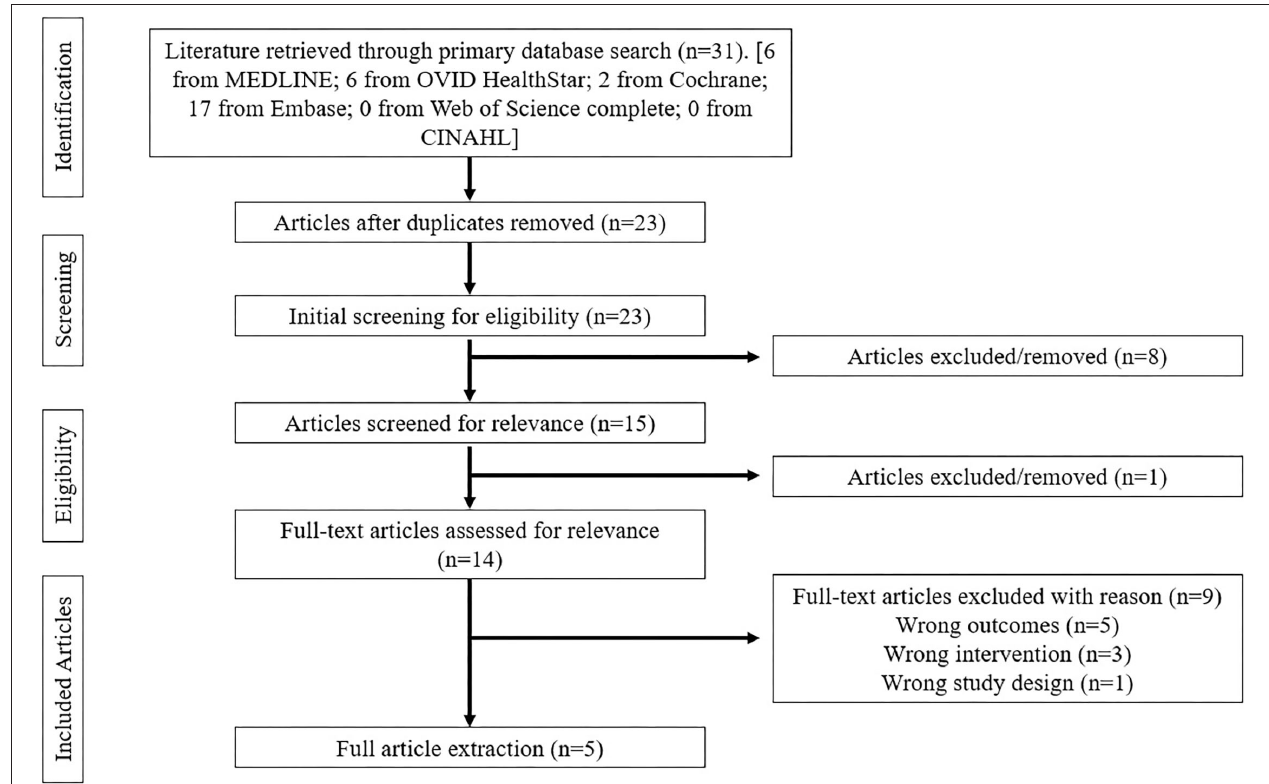
FIGURE 1 | PRISMA flow-chart of literature search strategy and results.